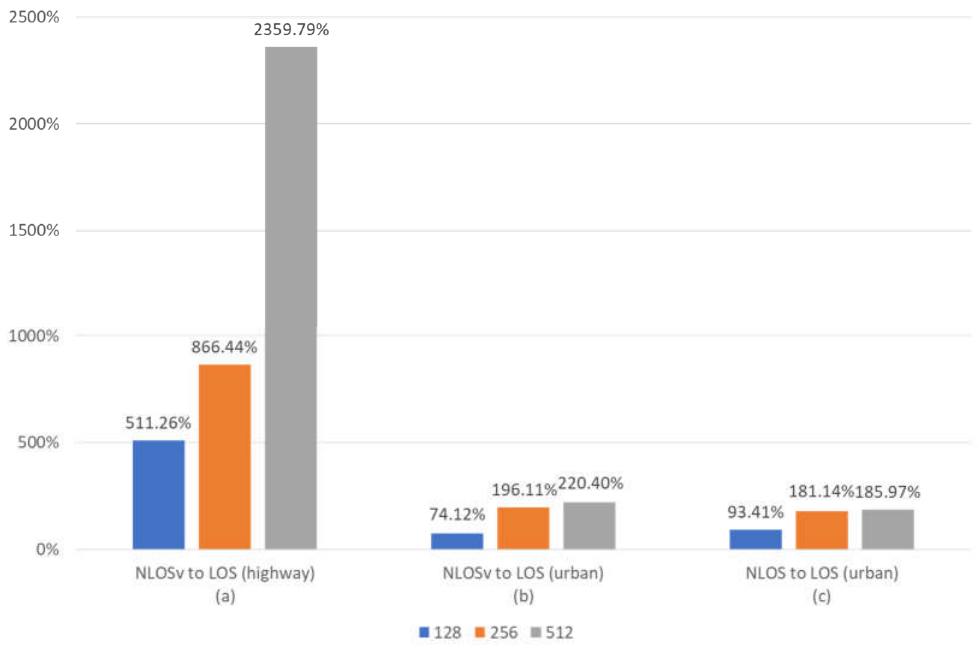
Figure 7. Mean percentage BER improvement when the channel state changes for maxlogBCJR and for 128-, 256- and 256-bit frames. ( a ) BER improvement for channel state change from to NLOSv to LOS in a highway traffic model. ( b ) BER improvement for channel state change from to NLOSv to LOS in an urban traffic model. ( c ) BER improvement for channel state change from to NLOS to LOS in an urban traffic